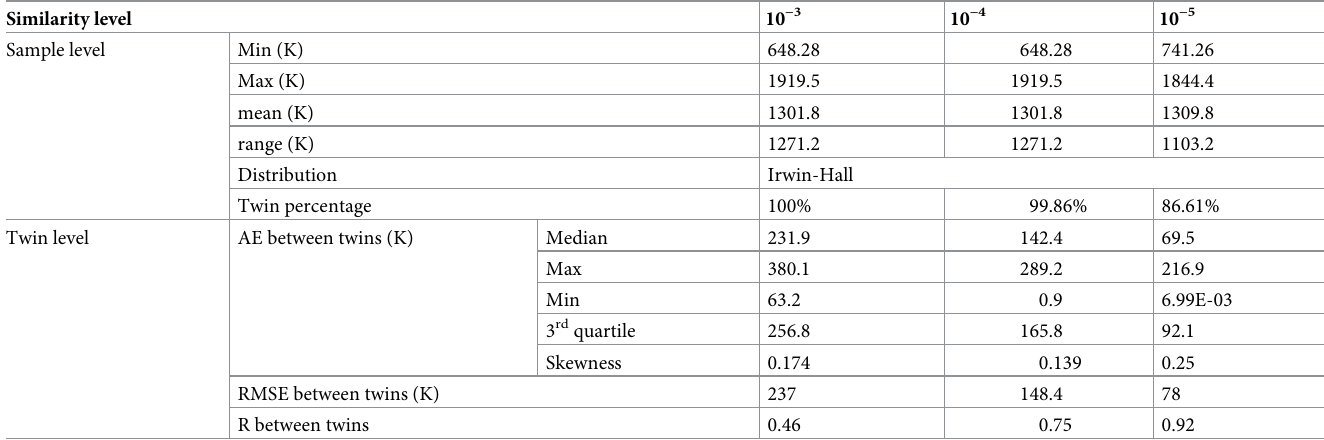
Table 1. Statistics of datasets of spectral twins.